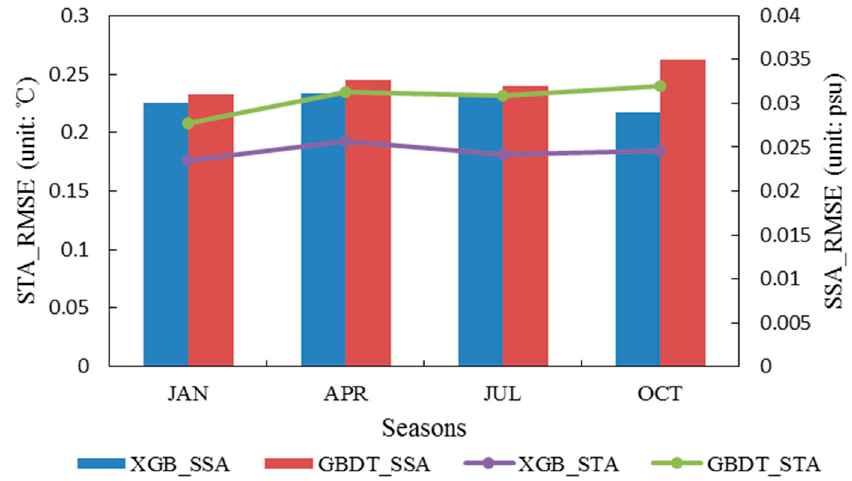
Figure 2. The average root-mean-square error (RMSE) for the 23 depth levels of STA and SSA estimated using XGBoost and GBDT in different seasons (the lines indicate the RMSE of the STA and the bars indicate the RMSE of the SSA).